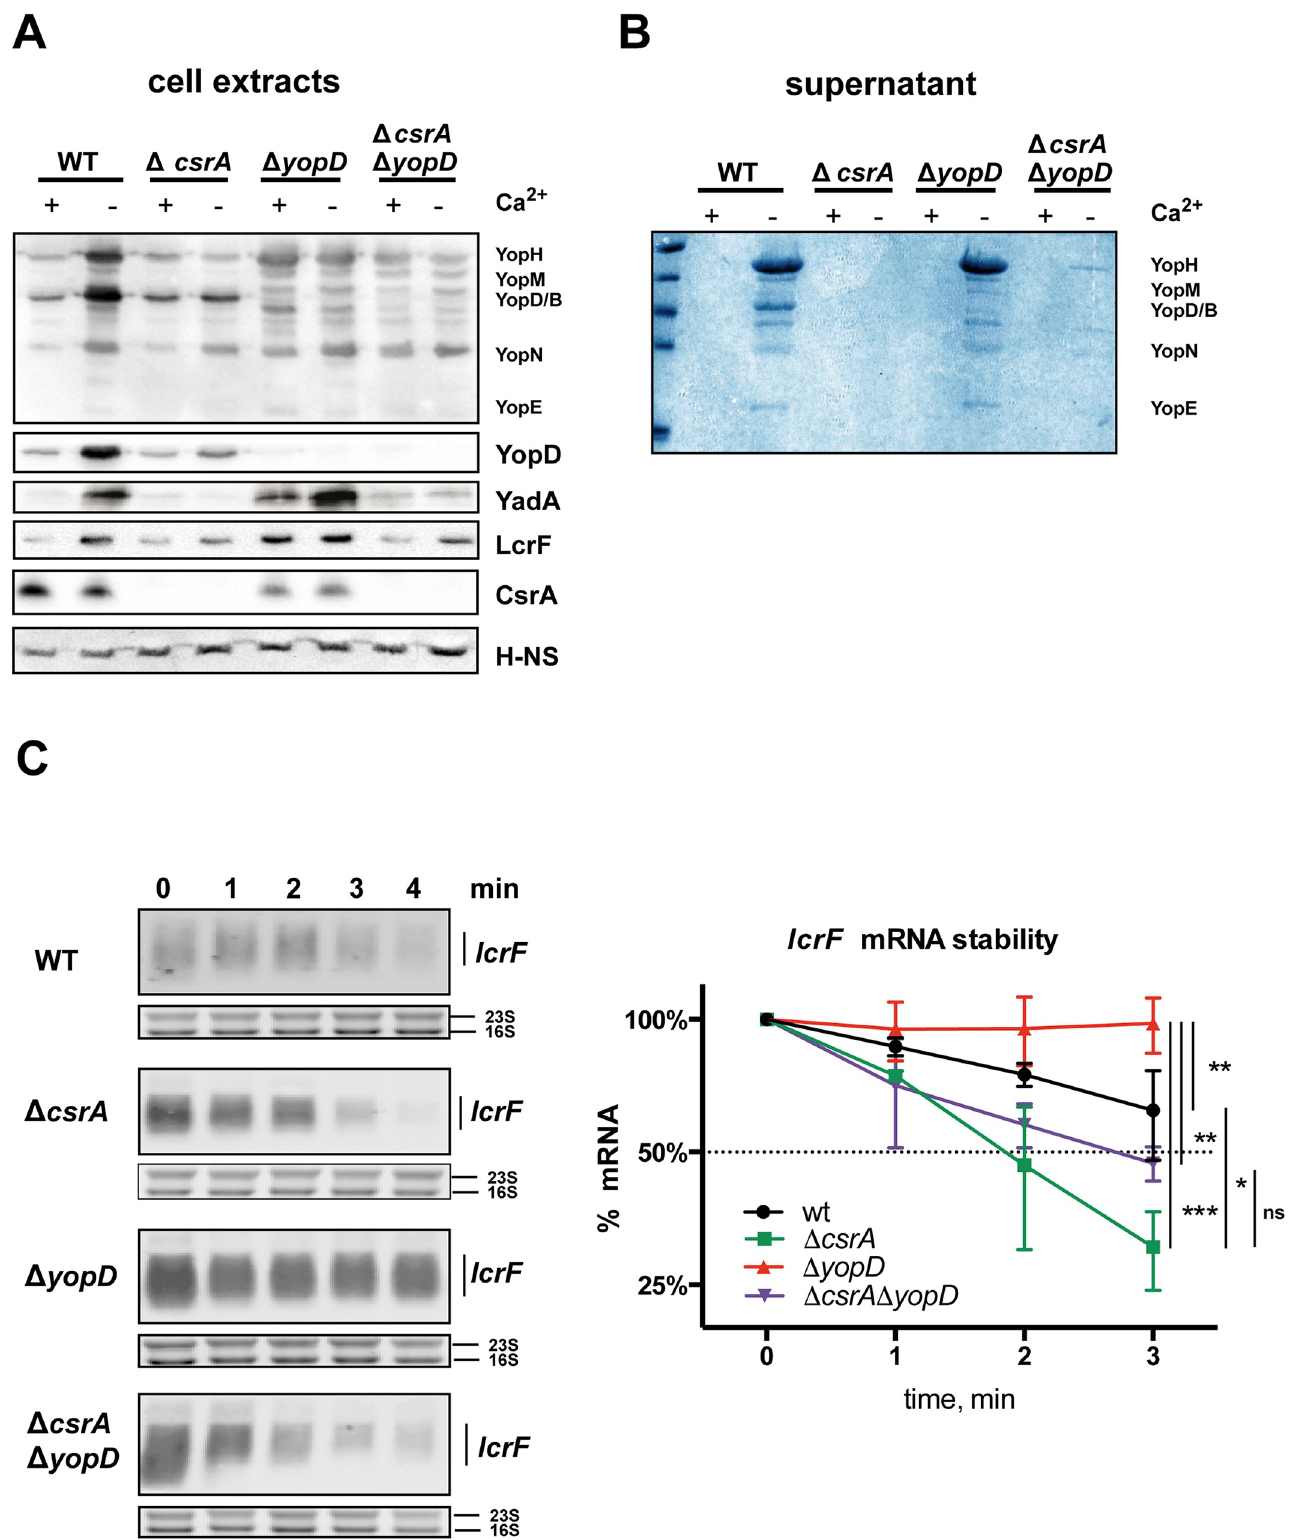
Fig 6. Influence of CsrA and YopD on the expression of Yops, YadA and LcrF. Strains YPIII, YP53 ( Δ csrA ), YP91 ( Δ yopD ), and YP145 ( Δ csrA , Δ yopD ) were grown in LB at 37˚C in the absence (non-secretion conditions) or presence of 20 mM MgCl 2 and 20 mM sodium oxalate for 4 h (secretion conditions). (A)